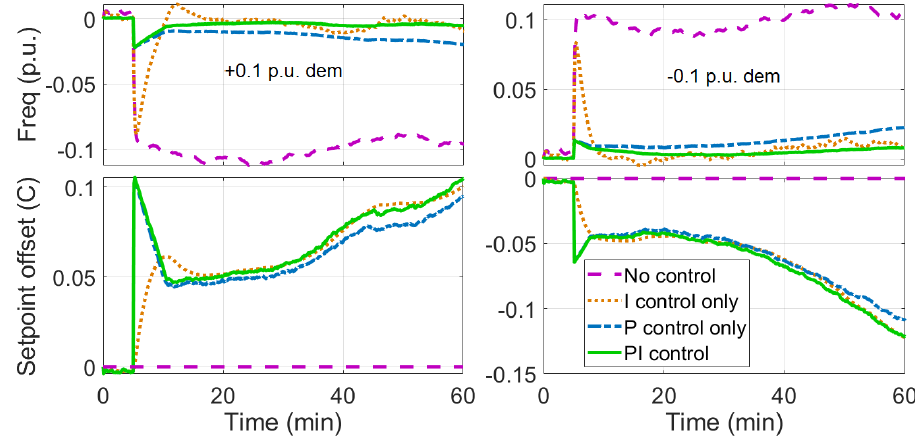
Figure 10. TCL-based transactive frequency control simulation for ±10% step change in load: 10% load increase ( left ), and 10% load cut ( right ).